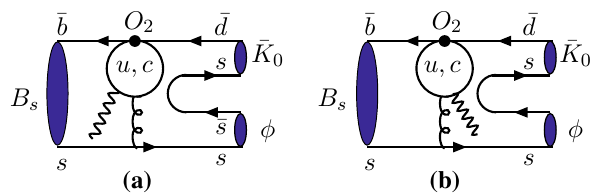
Fig. 4 Feynman diagrams of loop line photon emission. The charm or up loop to the gluon is attached to the spectator quark line. A photon is emitted through the quark-loop line